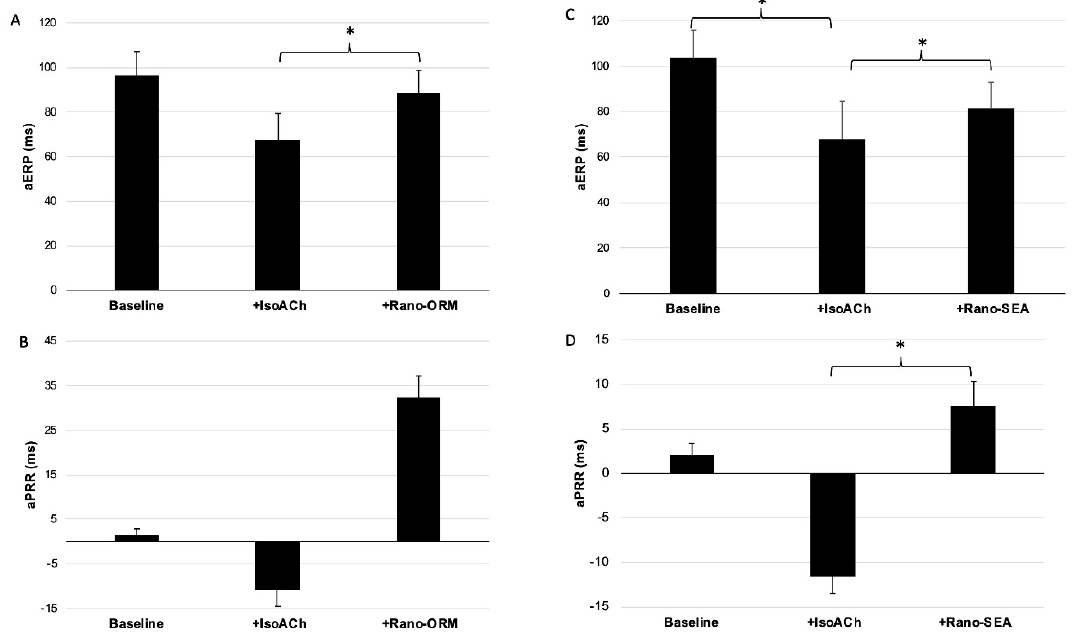
Figure 2. ( A , B ) the influence of additional perfusion with isoproterenol / acetylcholine and ranolazine / ORM-10103 on aERP ( n = 9) ( A ) and atrial post repolarization refractoriness (aPRR) ( n = 9) ( B ) (*: p < 0.05). ( C , D ) the influence of additional perfusion with isoproterenol / acetylcholine and ranolazine/SEA-0400 on aERP ( n = 9) ( C ) and aPRR ( n = 9) ( D ) (*: p < 0.05).